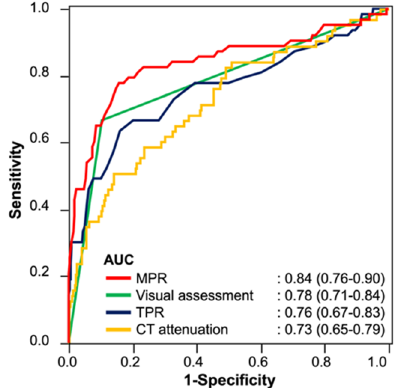
Figure 2. ROC curves of MPR, TPR, endocardial CT attenuation, and visual assessment for the detection of myocardial perfusion abnormality. The AUCs of MPR and visual assessment are comparable, and the AUC of MPR is significantly higher than those of TPR and endocardial CT attenuation. The 95% confidence intervals of the AUCs are shown in parentheses. ROC, receiver operating characteristic; MPR, myocardial perfusion ratio; TPR, transmural perfusion ratio; CT, computed tomography; AUC, area under the curve.